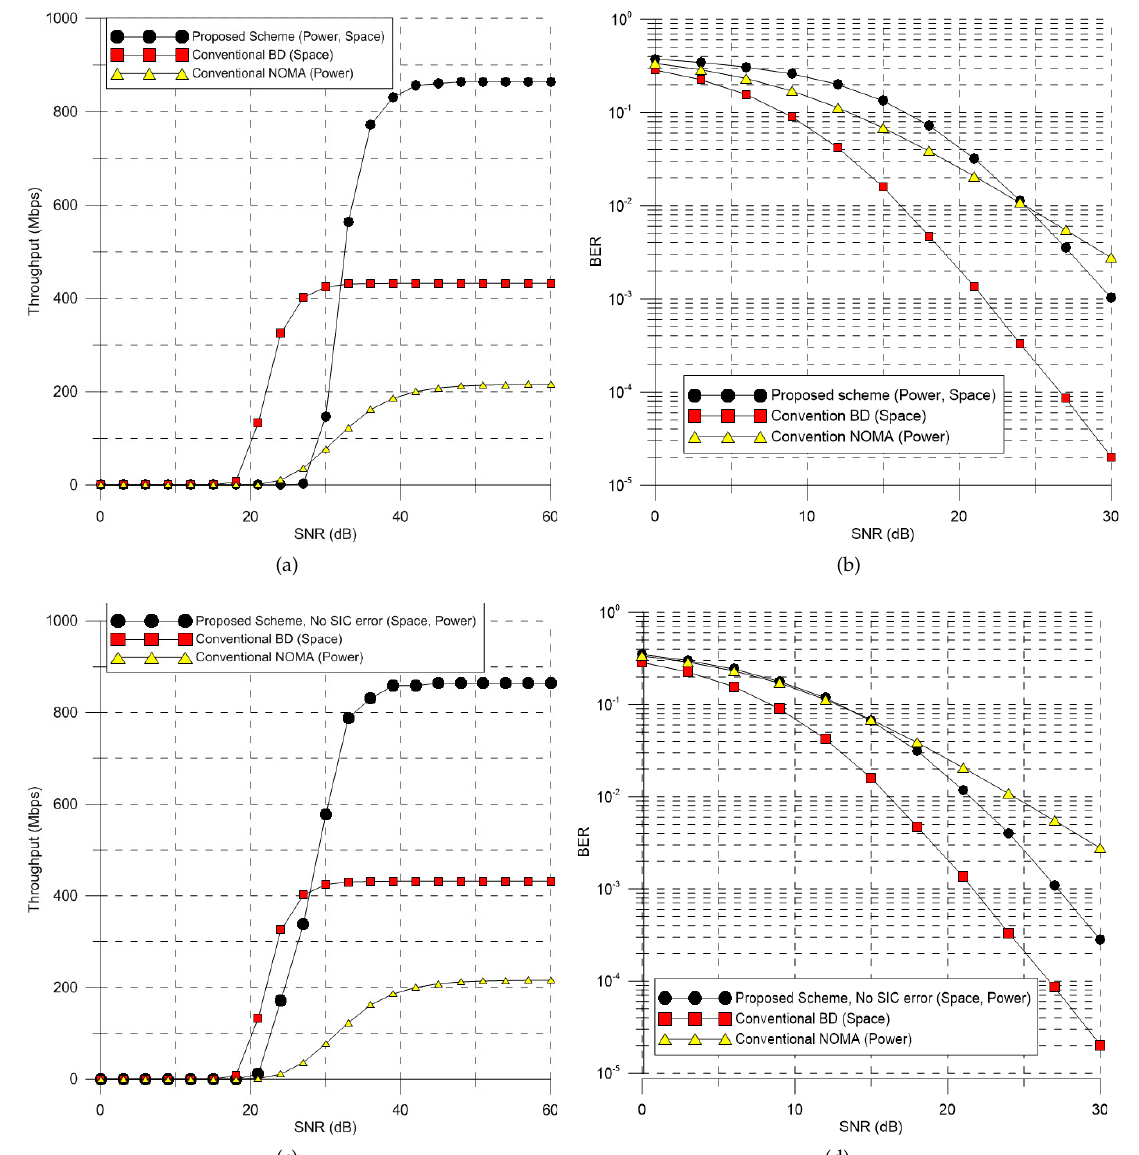
Figure 7. Throughput and BER performance of conventional and proposed schemes: ( a ) Throughput performance with SIC error; ( b ) BER performance with SIC error; ( c ) Throughput performance without SIC error; ( d ) BER performance without SIC